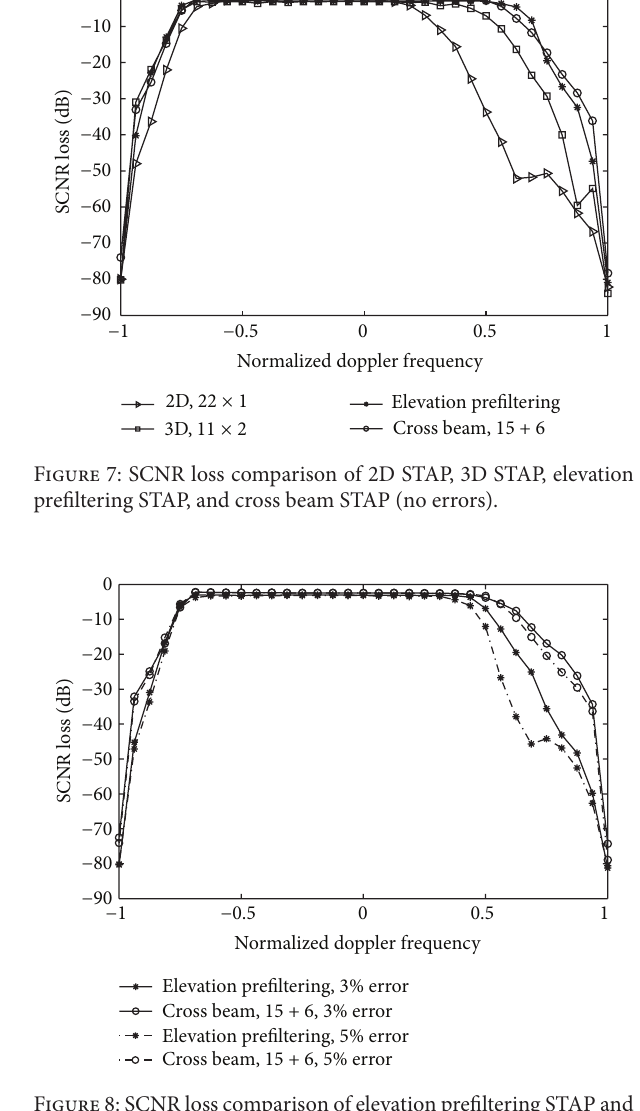
Figure 8: SCNR loss comparison of elevation prefiltering STAP and cross beam STAP with different